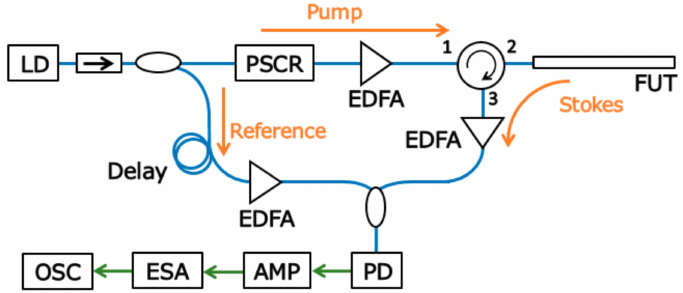
Figure 7. Experimental setup of slope-assisted BOCDR. AMP, amplifier; EDFA, erbium-doped fiber amplifier; ESA, electrical spectrum analyzer; FUT, fiber under test; LD, laser diode; OSC, oscilloscope; PD, photodiode; PSCR, polarization scrambler. Reproduced with permission from [59]. Copyright (2016)